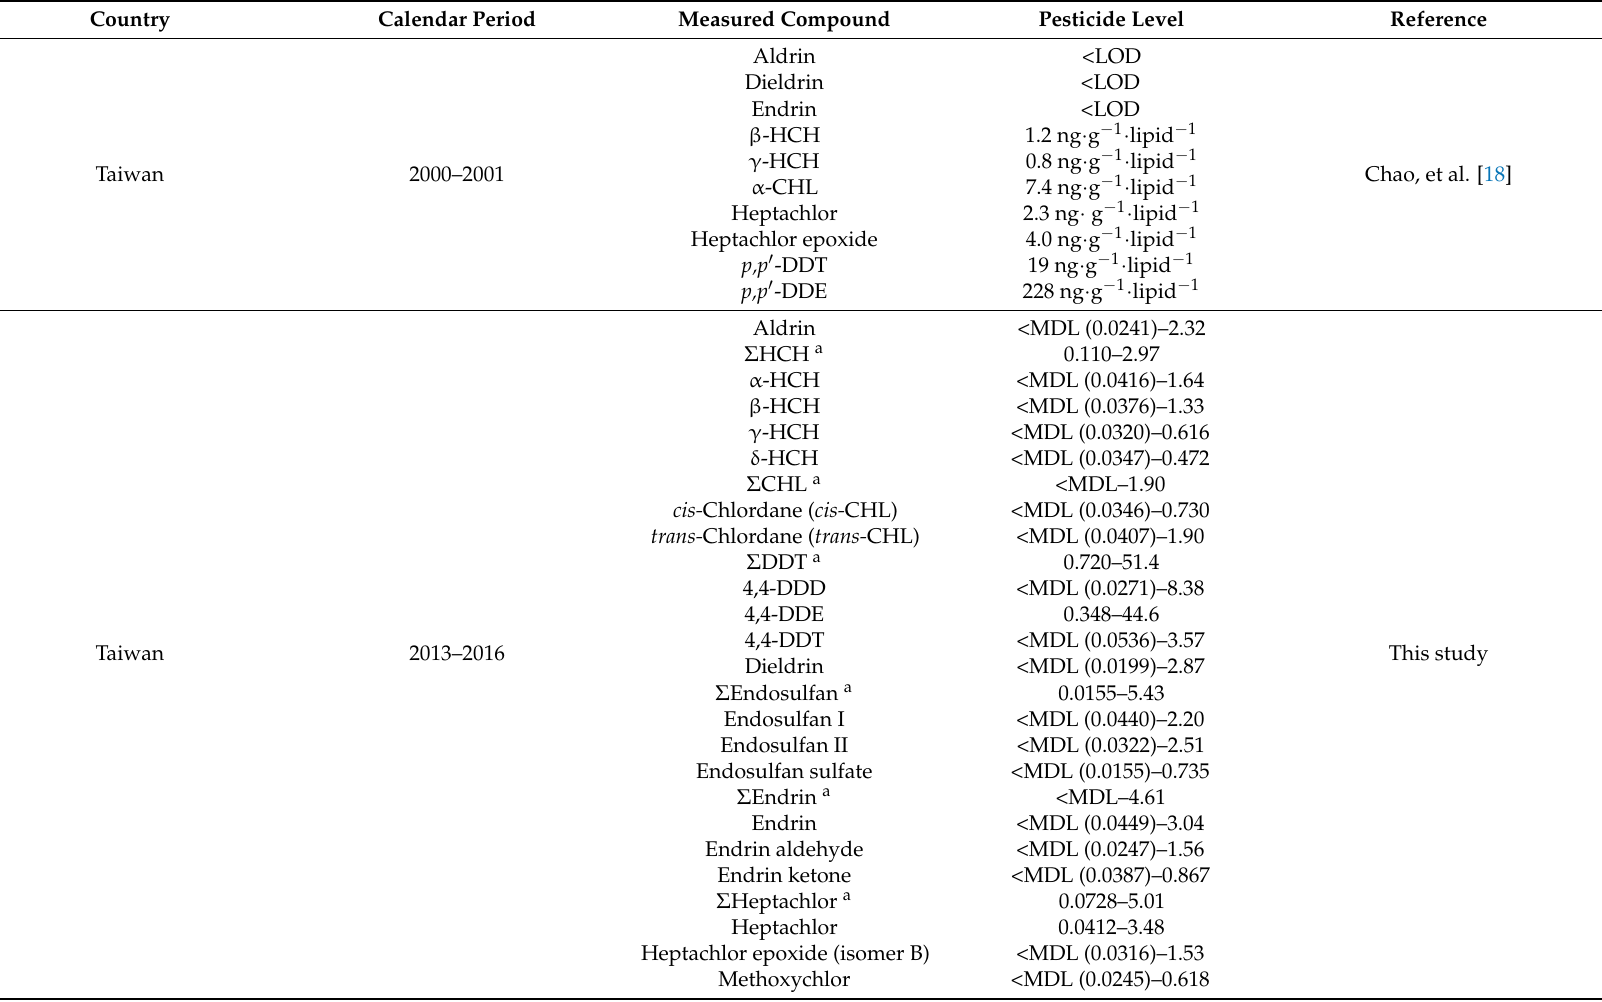
Table 6. OCP levels in breast milk in different